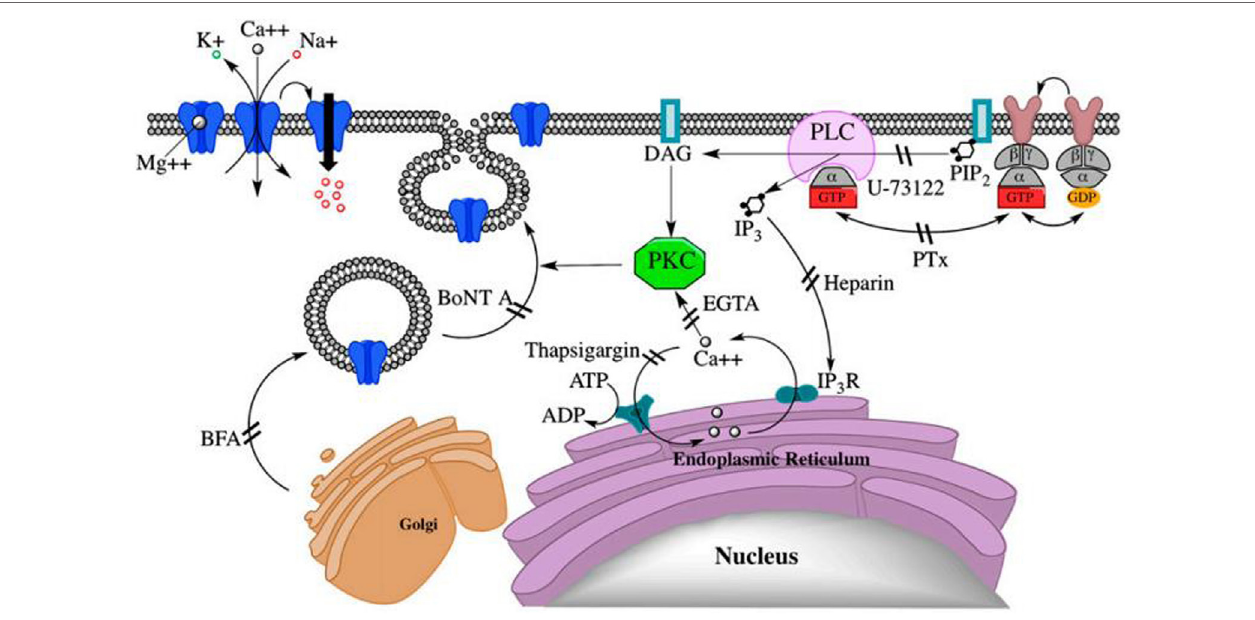
FiGURe 2 | PregS-stimulated trafficking of functional N -methyl- d -aspartate (NMDA) receptors to the cell surface via a non-canonical G protein-, PLC-, Ca2 + -, and protein kinase C (PKC)-dependent mechanism. DAG, diacylglycerol; IP3R, IP3 receptor; NMDA, ( N )methyl- d -aspartate; PIP2, phosphatidylinositol 4,5-bisphosphate